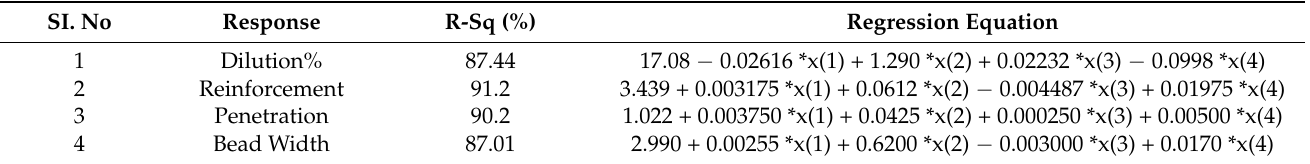
Table 6. Developed linear regression equations for responses.